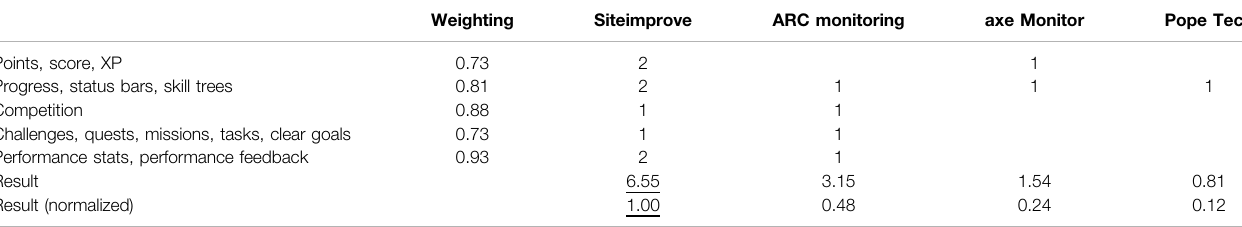
TABLE 6 | Gami fi cation patterns results.